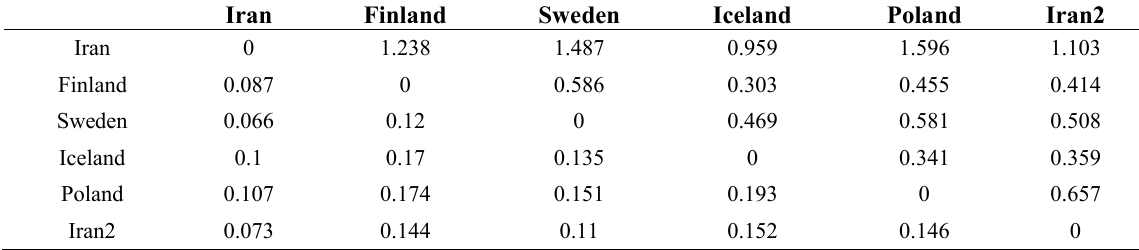
Table 4. Pairwise estimated genetic distance based on Fst value (Below) and gene flow (Above).